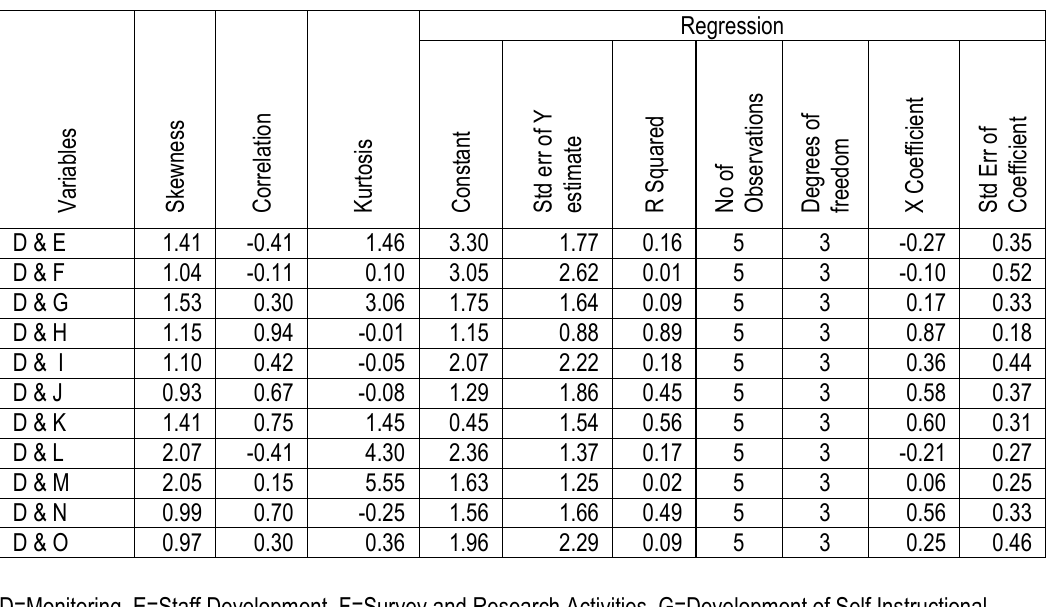
Table 5. Relationship of Monitoring with other Variables